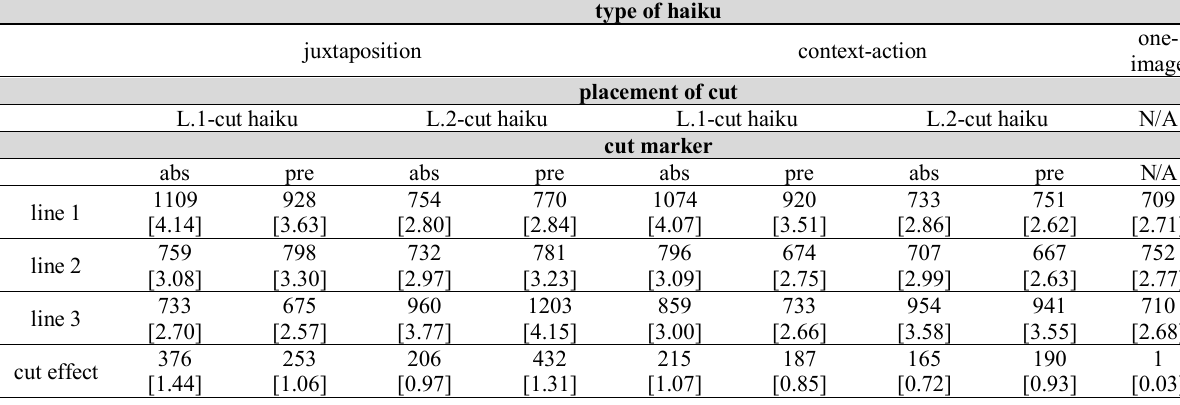
Table 1 . Total dwell times (in milliseconds; number of fixations given in parentheses) per word, corrected for differential line lengths (in terms of number of words), for the three poem lines. As can be seen, readers spent overall more time in the fragment line (line 1 in L.1-cut haiku and line 3 in L.2-cut haiku) relative to the [remote] phrase line (line 3 in L.1-cut and line 1 in L.2-cut haiku). The extended time spent on the fragment line is referred to as cut effect (last row of table). Abbreviations: abs=absent; pre=present. type of haiku juxtaposition context-action